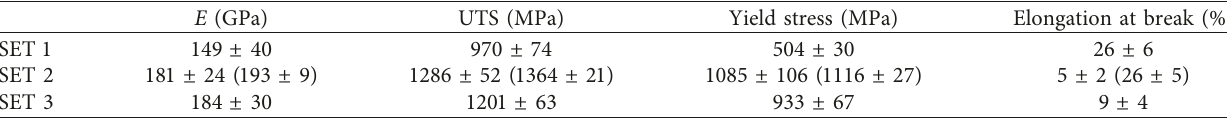
Figure 15: Yield strength (a), ultimate tensile strength (b), and elongation at break (c) of set 1, set 2, and set 3 with respect to orientation angle from build plate. Points indicate measured values while the lines in elongation indicate the least square fit. Table 8: Average tensile properties for all eleven orientations. Values for the reference specimens (machined from rolled and aged IN718) are given in parenthesis.